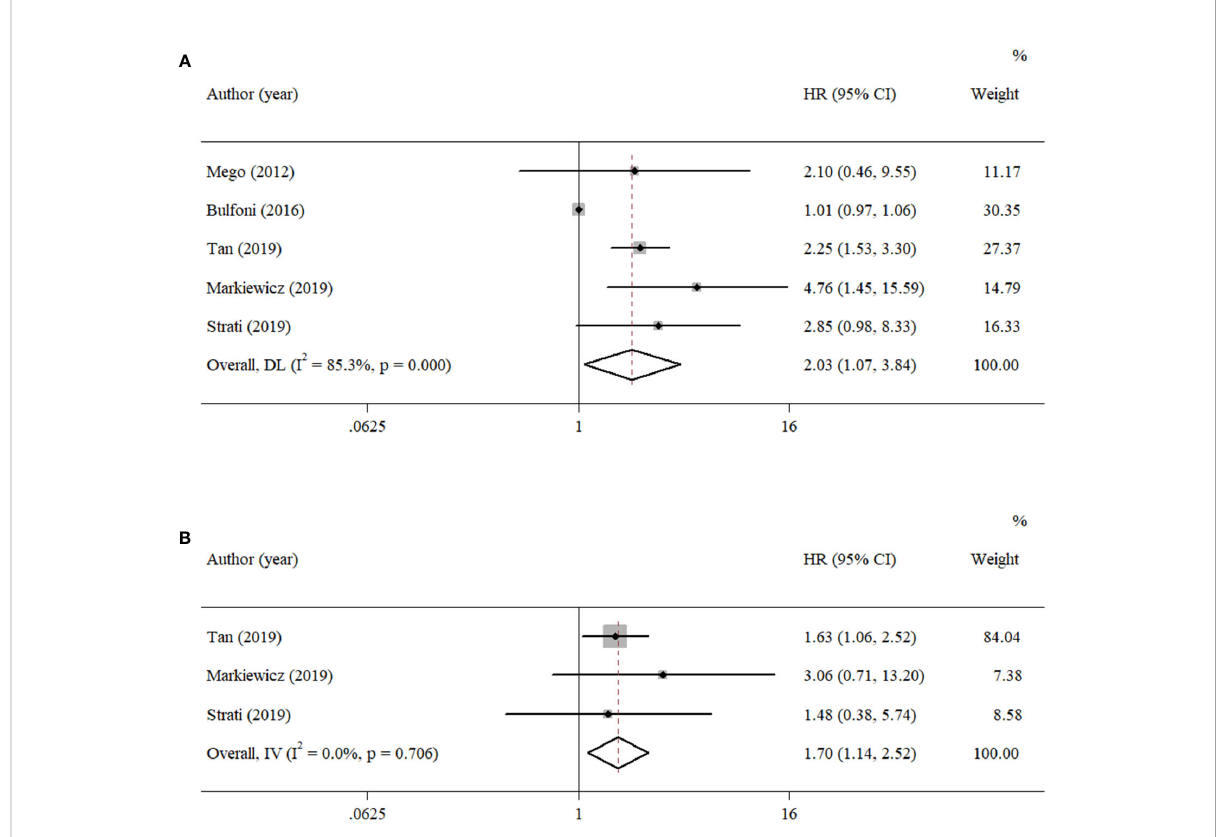
FIGURE 3 Forest plots of the pooled HRs for OS with (A) univariate analysis and (B) multivariate